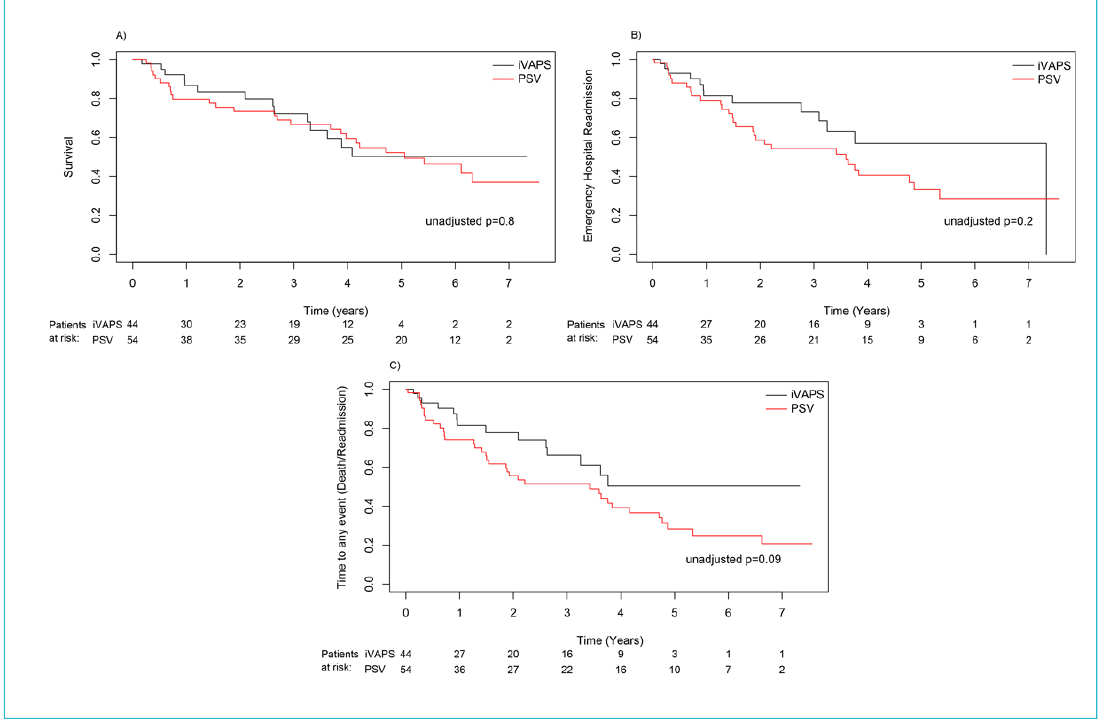
Figure 2: Kaplan-Meier curves for survival (A), emergency hospital readmission (B) and time to any event (death, readmission) (C) according to ventilator mode. iVAPS = intelligent volume assured pressure support; PSV = pressure support